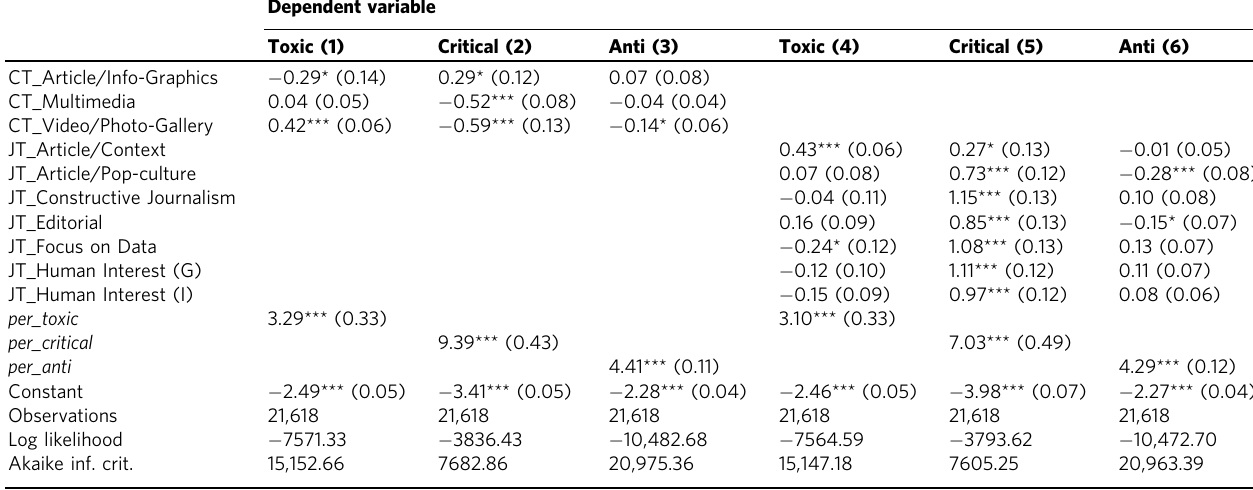
Table 5 Speci fi cation of the logistic regression